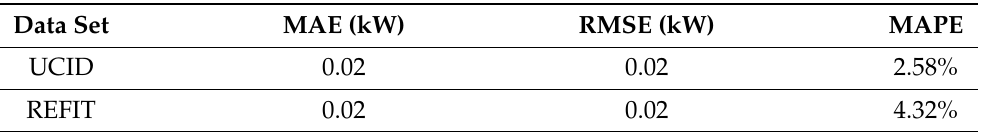
Table 5. Performance metrics obtained when applying our method on the trend component of the UCID and the REFIT datasets to obtain one-step-ahead